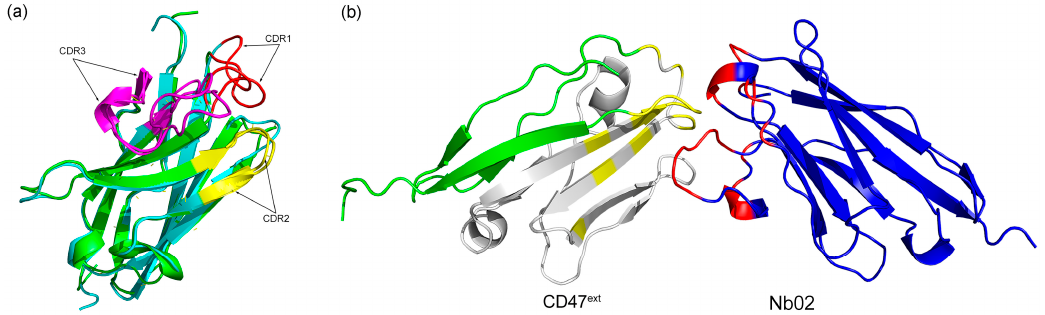
Figure 2. MD simulation of Nb02 and docking complex. ( a ) Nb02 end simulation conformation (green) alignment with parental VHH (cyan), CDRs are in red, yellow and purple, respectively. ( b ) Side view of Nb02-CD47 ext complex. The residues associated with the B6H12.2 binding sites (yellow) on the CD47 ext (green) and those of the CDRs (red) on the VHH (blue) is highlighted. The gray region presents the potential binding domain.